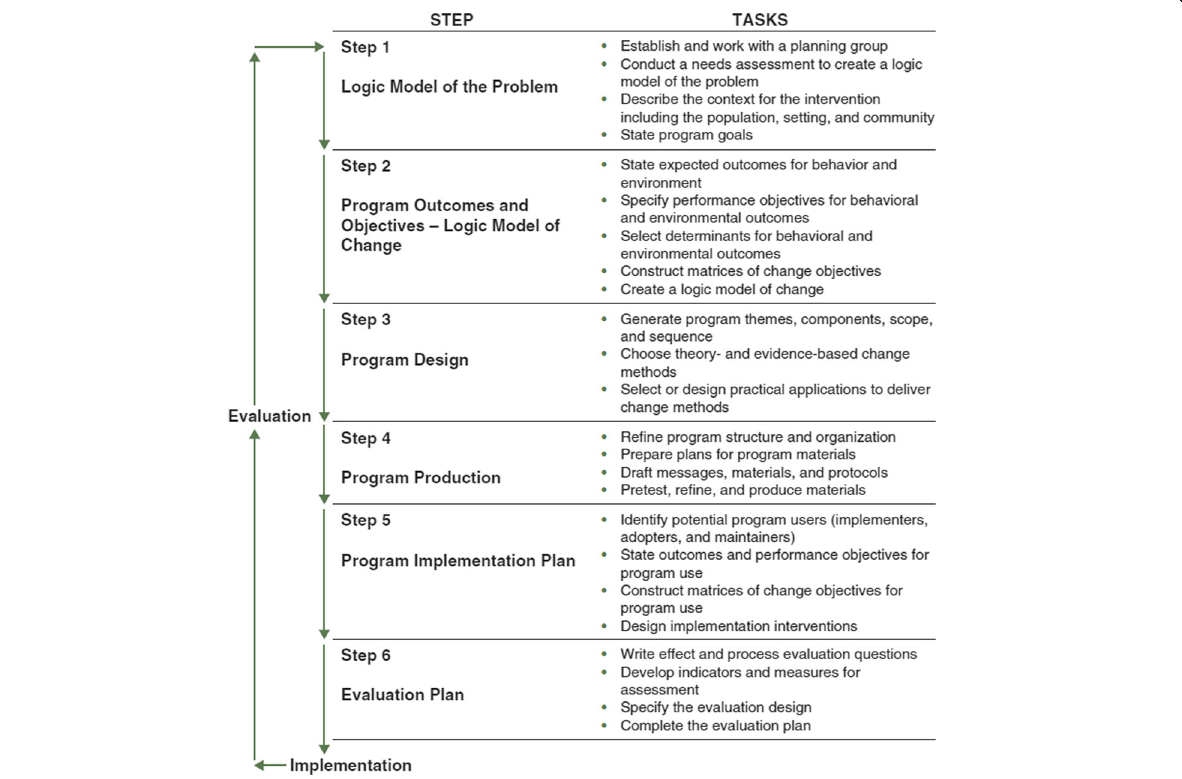
Fig. 2 Intervention Mapping Steps and